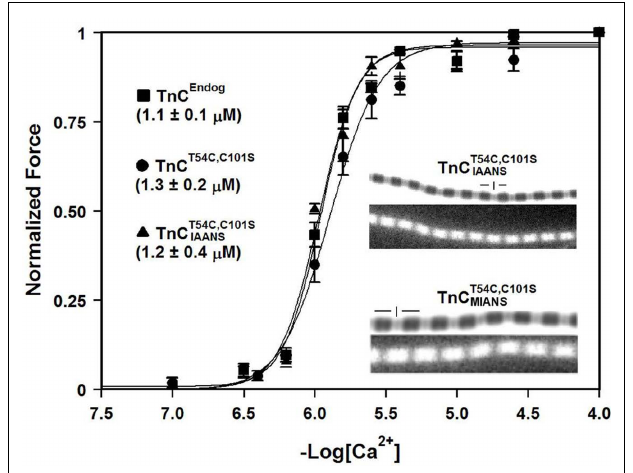
FIGURE 3 | Comparison of the calcium dependence of skeletal muscle force generation by native andTnC reconstituted fibers. The Ca 2 + dependence of isometric force generation in native ( (cid:3) TnC Endog ) single rabbit skinned psoas fibers is compared to that of fibers reconstituted with • TnC T54C,C101S ( ) orTnC T54C,C101S ( (cid:4) ) as a function of pCa.The experimental IAANS conditions are described in “Experimental Procedures.” Each data point represents the mean ± SE from at least four separate fibers individually normalized and fit with a logistic sigmoid function mathematically equivalent to the Hill equation.The inset shows the phase contrast (top of paired panels) and IAANS or MIANS fluorescence (bottom of paired panels) images obtained from representative rigor psoas myofibrils reconstituted withTnC T54C,C101S orTnC T54C,C101S .The vertical lines designate the location of IAANS MIANS the Z-lines, and the horizontal lines designate the location of the A bands.